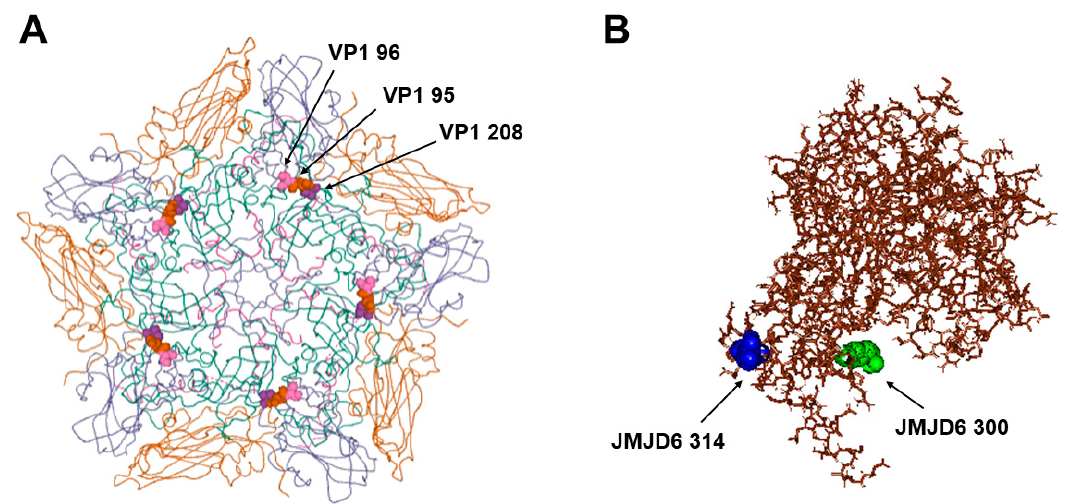
Figure 5. Relative locations of amino acid residues reported in a previous study and this study on the three-dimensional structural model of the FMDV pentamer and the JMJD6 protein. ( A ) The amino acid residues at positions VP1 95 and 96 [15], and VP1 208 (this study) are indicated in the outer schematic view of a pentameric subunit (O PanAsia, PDB accession no. 5NE4). The protein subunits of VP1, VP2, VP3, and VP4 are colored cyan, yellow, violet, and pink, respectively. ( B ) Amino acid residues 314 [15] and 300 (this study) are indicated in the JMJD6 protein.